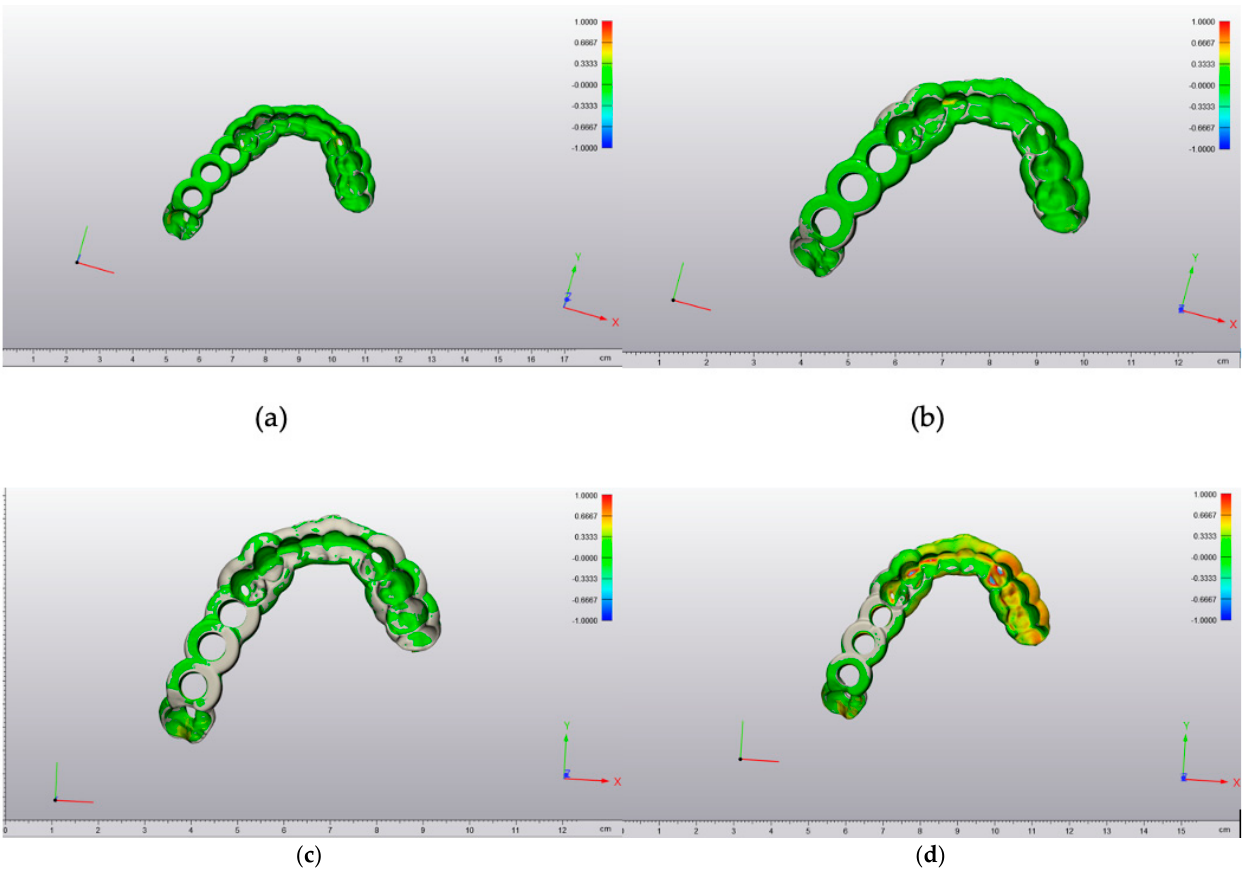
Figure 3. Color-coded deviation maps within each 3D printing technology: ( a ) MJ ( b ) SLA ( c ) FFF ( d ) DLP technology, scale in cm.